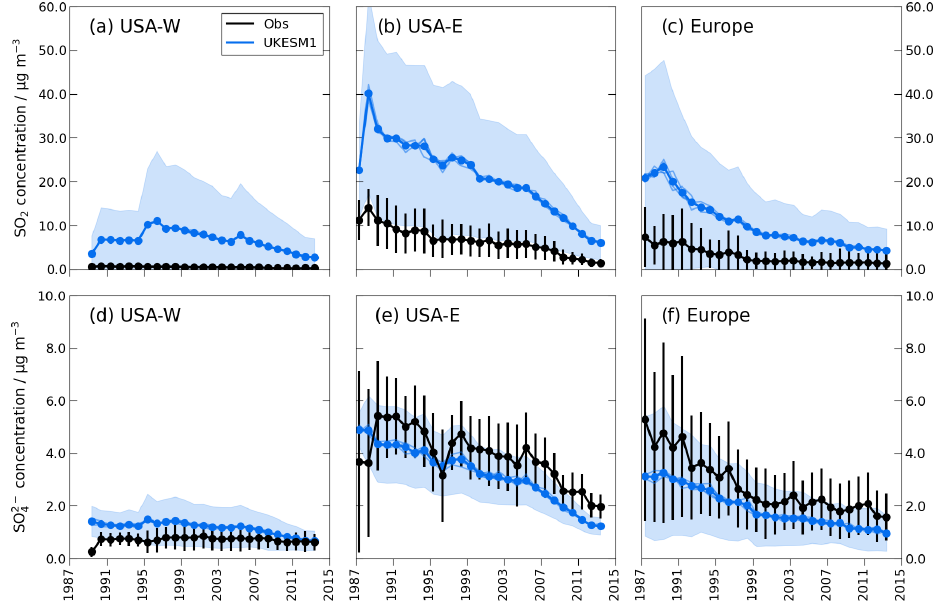
− (d–f) concentrations for USA–W ( a, d ; N 4 ). Each point in the time series represents 4 (d–f) . 4